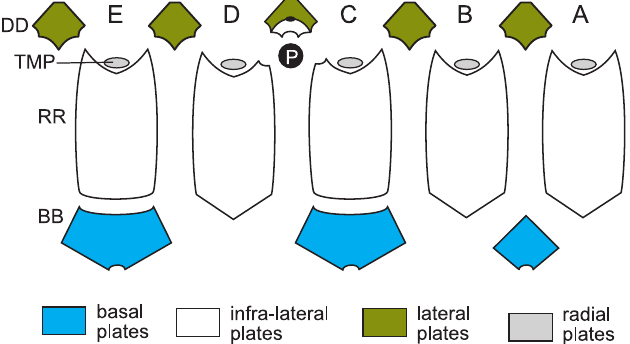
34.Fig. 12. Thecal plates of coronates showing homologies with blastoid plates. A–E, Carpenter’s (1884, 1891) ambulacra; BB, basal plates; DD, del toid plates; P, periproct; RR, radial plates; TMP, “trunk mounting plates”, which bear facets for erect ambulacra and are homologues of blastoid lancet plates and glyptocystitoid radial plates. White plate above the periproct is the ex- tra deltoid plate and small black oval above that is the gonopore. For plate homologies see Table